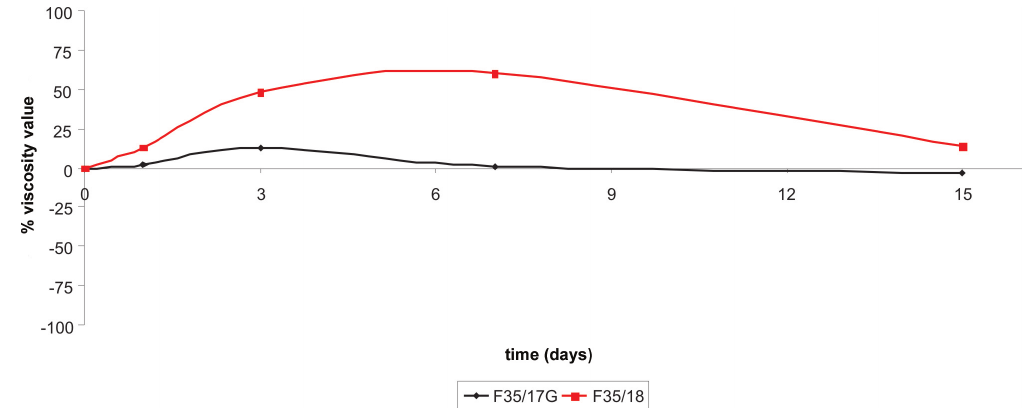
FIGURE 5 - Percentage variation of Apparent viscosity value for the test formulations F35/18 and F35/17G in the Oven (45.0 ± 2.0 ºC) storage condition in the Accelerated Stability Study